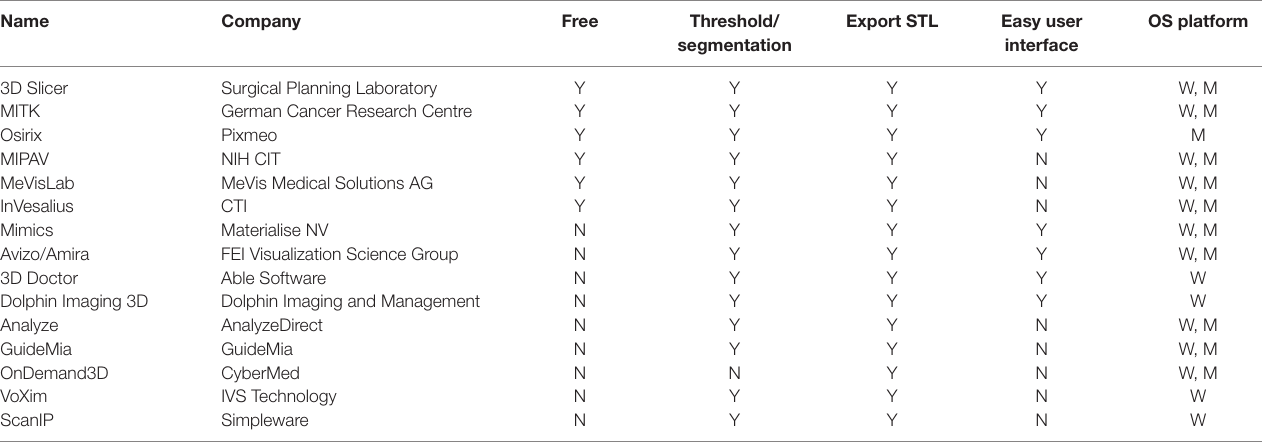
TABLe 2 | A summary of 3D modeling softwares that can convert a DiCOM data from a standard CT/MRi scans into a CAD